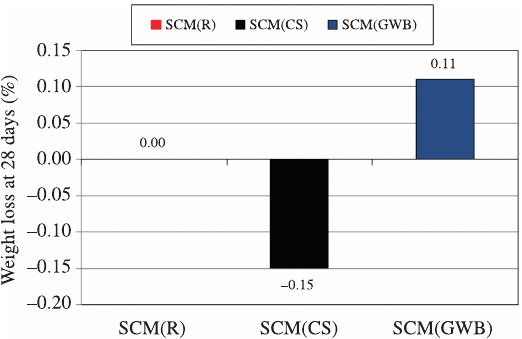
Figure 11. Evolution of weight loss of the SCMs mortars as function